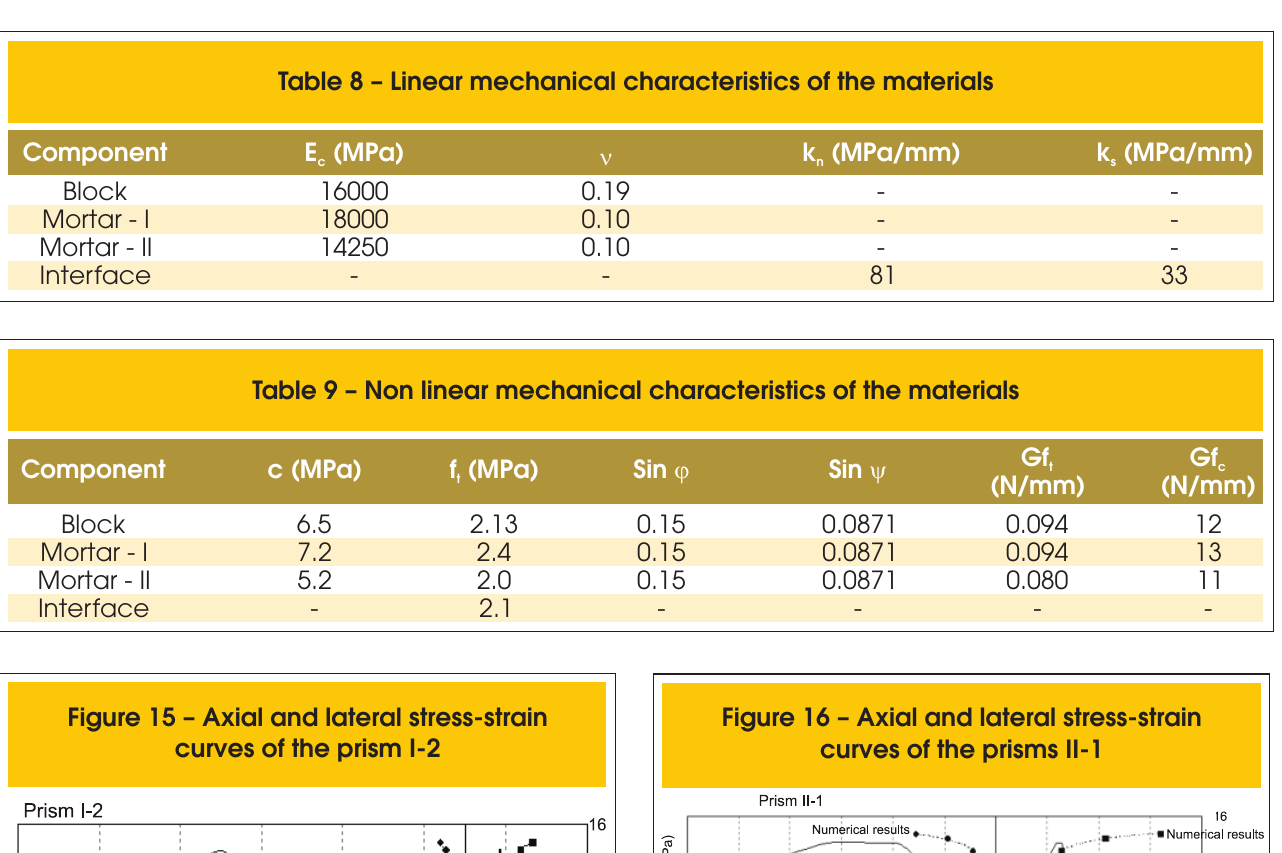
Figure 16 – Axial and lateral stress-strain curves of the prisms